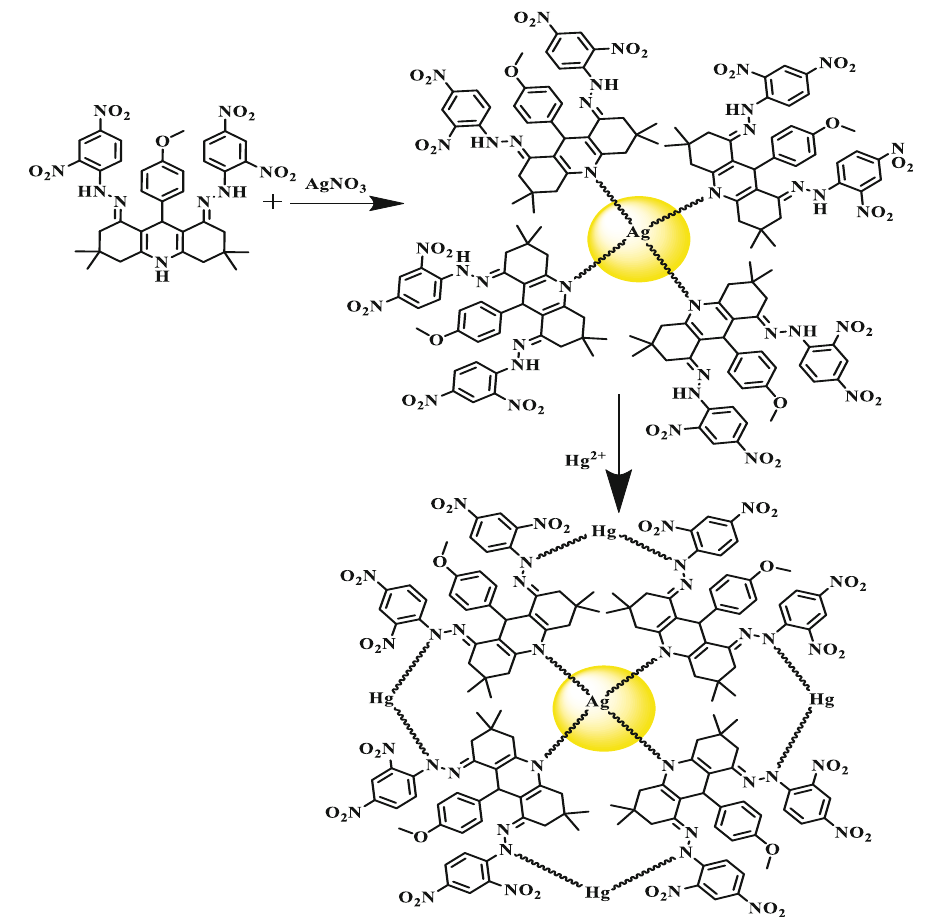
Figure 4: Schematic representation of nanoparticles synthesis and complexation with Hg 2+